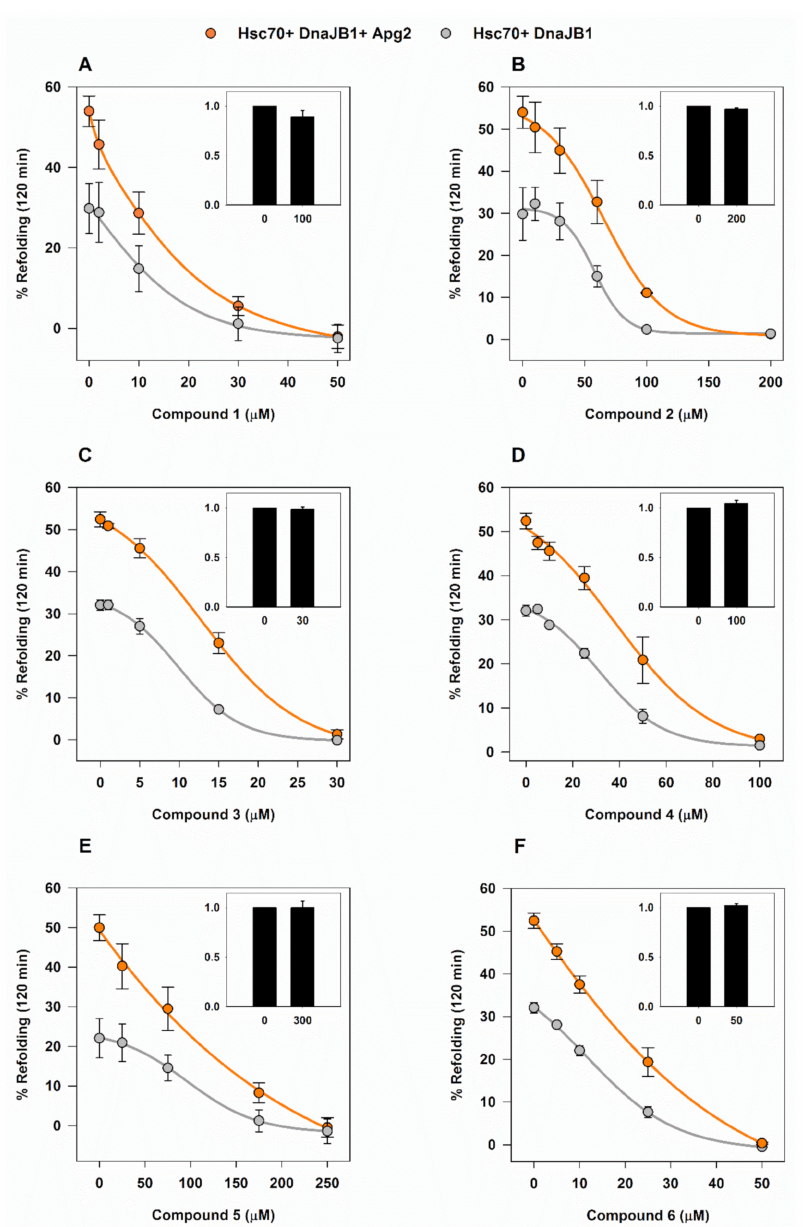
Figure 3. Chaperone-mediated reactivation of G6PDH aggregates in the presence of the selected compounds. ( A – F ) The effect of compounds 1–6 on the Hsp70-based disaggregase system was analyzed by following their effectiveness to reactivate G6PDH aggregates (0.4 µ M) obtained after denaturing and aggregating the client protein at 50 ◦ C during 30 min. Samples contained 2 µ M Hsc70 and 0.5 µ M DnaJB1 either without (light grey) or with 0.4 µ M Apg2 (orange). Values are shown as the means ± SD of three independent experiments. Insets, effect of the highest compound concentration on the activity of native G6PDH, relative to control samples without